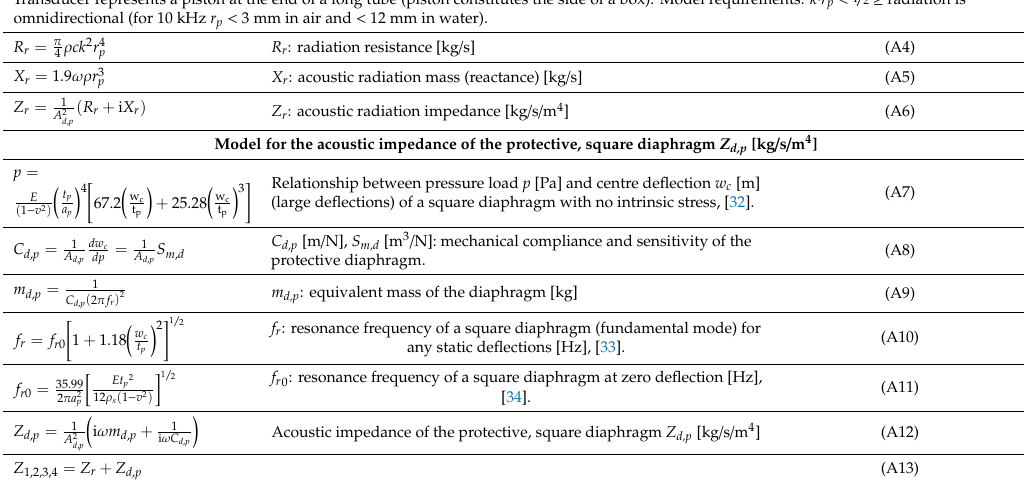
Table A3. Lumped parameter model for the acoustic radiation impedance Z r and acoustic impedance of a protective diaphragm Z p,d